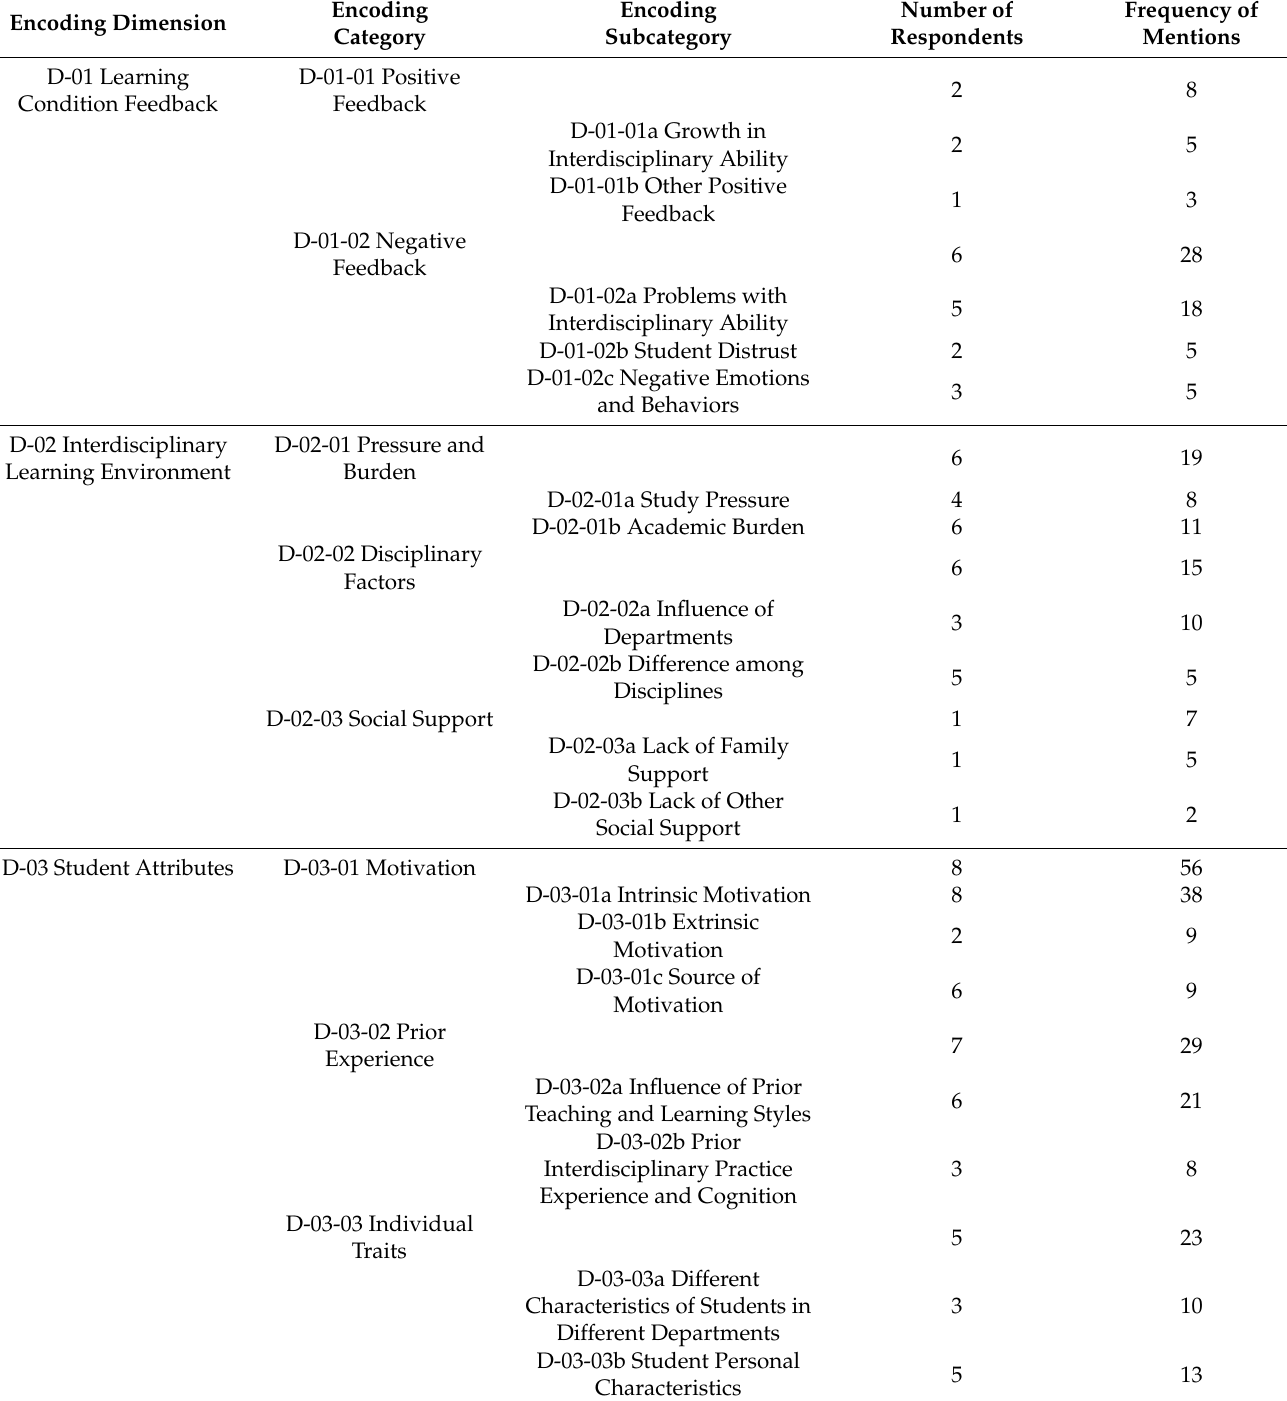
Table 7. Codes and